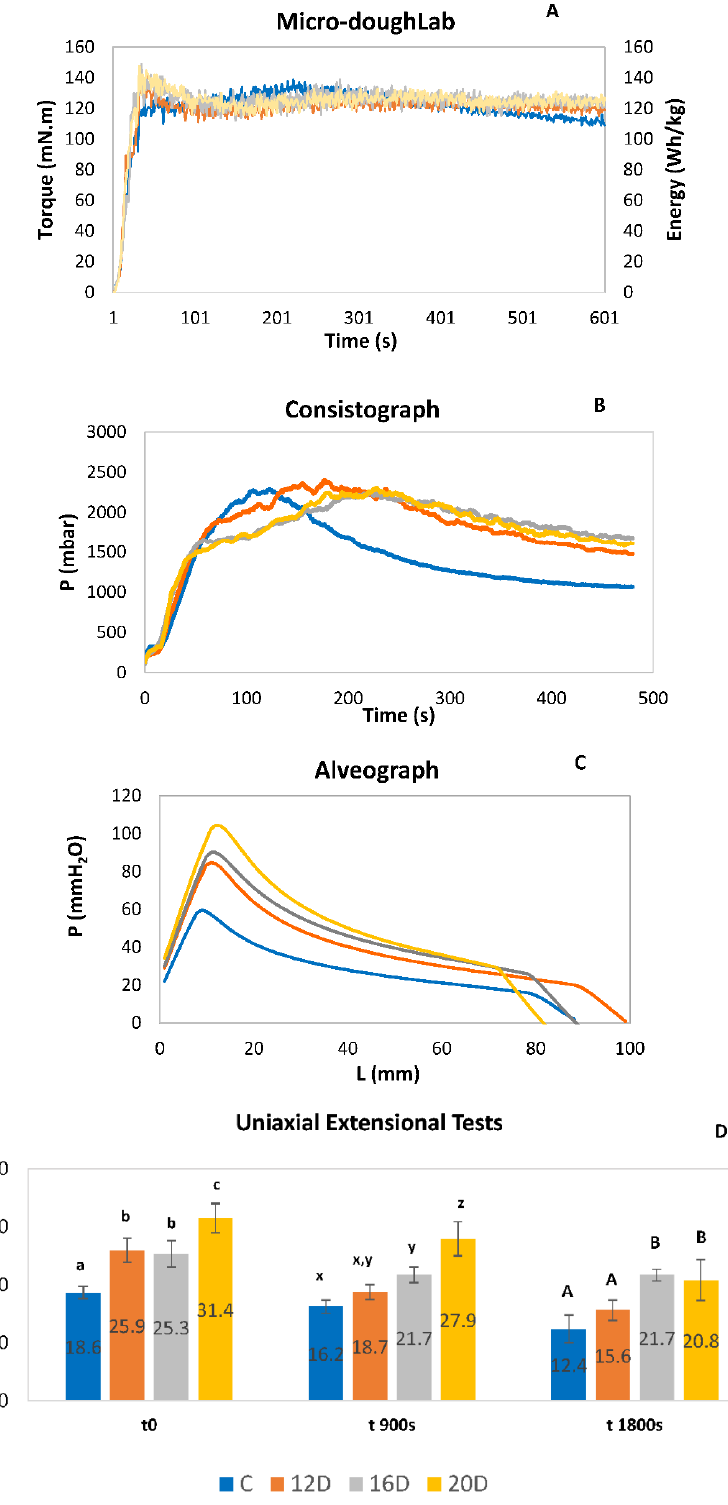
Figure 1. Curves obtained with Micro-doughLab ( A ), Consistograph ( B ) and Alveograph ( C ) and R/E values obtained from the extensional tests in the Texturometer (Kieffer dough rig) along fermentation (t0, t 900 s and t 1800 s) ( D ). C: control dough without whey; 12D: dough with 12% whey; 16D: dough with 16% whey; 20D: dough with 20% whey. Error bars indicate the standard deviations from the repetitions. Different letters (a, b, c or x, y, z or A, B) correspond to significant differences (one-way ANOVA, p < 0.05).